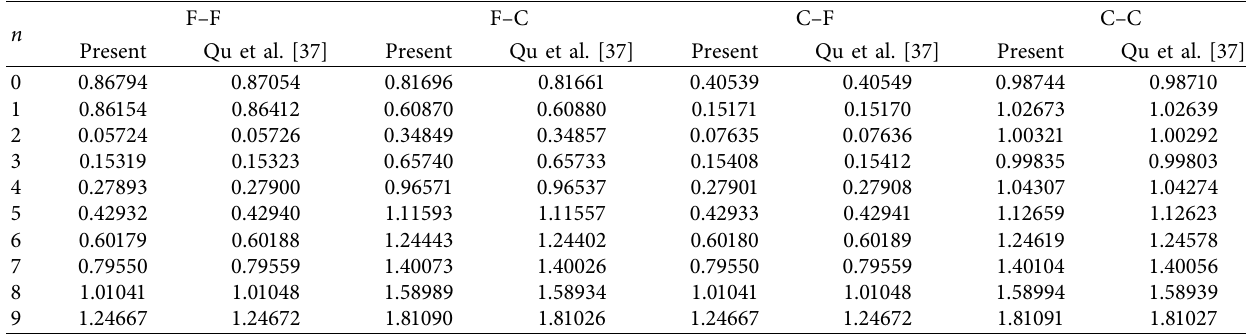
Table 3: Comparison of the results for the annular spherical shell ( m �